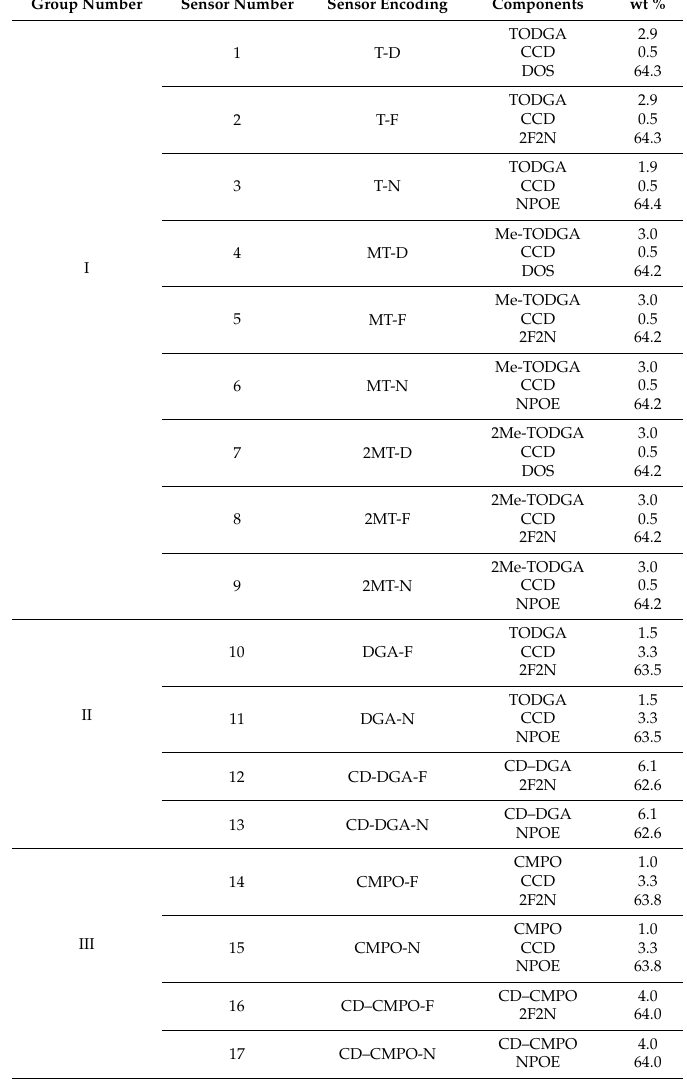
Table 1. Compositions of the sensor membranes. All membranes contained 31–32 wt % of poly(vinyl chloride)